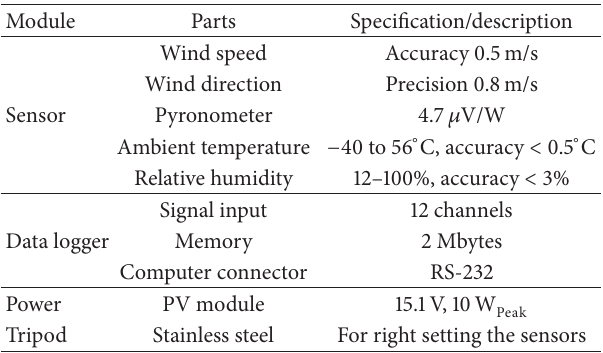
Table 1: Main characteristics of the Solar-Wind Meteorological Station at the Solar Energy